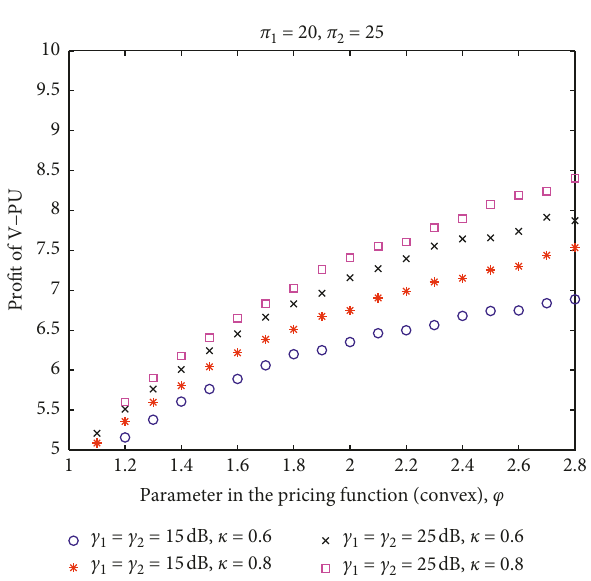
Figure 3: The profit of the V-PU vs. φ , on transmission link